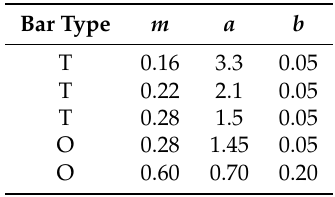
Table 4. Constants of Equation (10) for the adjustment of the mean discharge coefficient C qH .